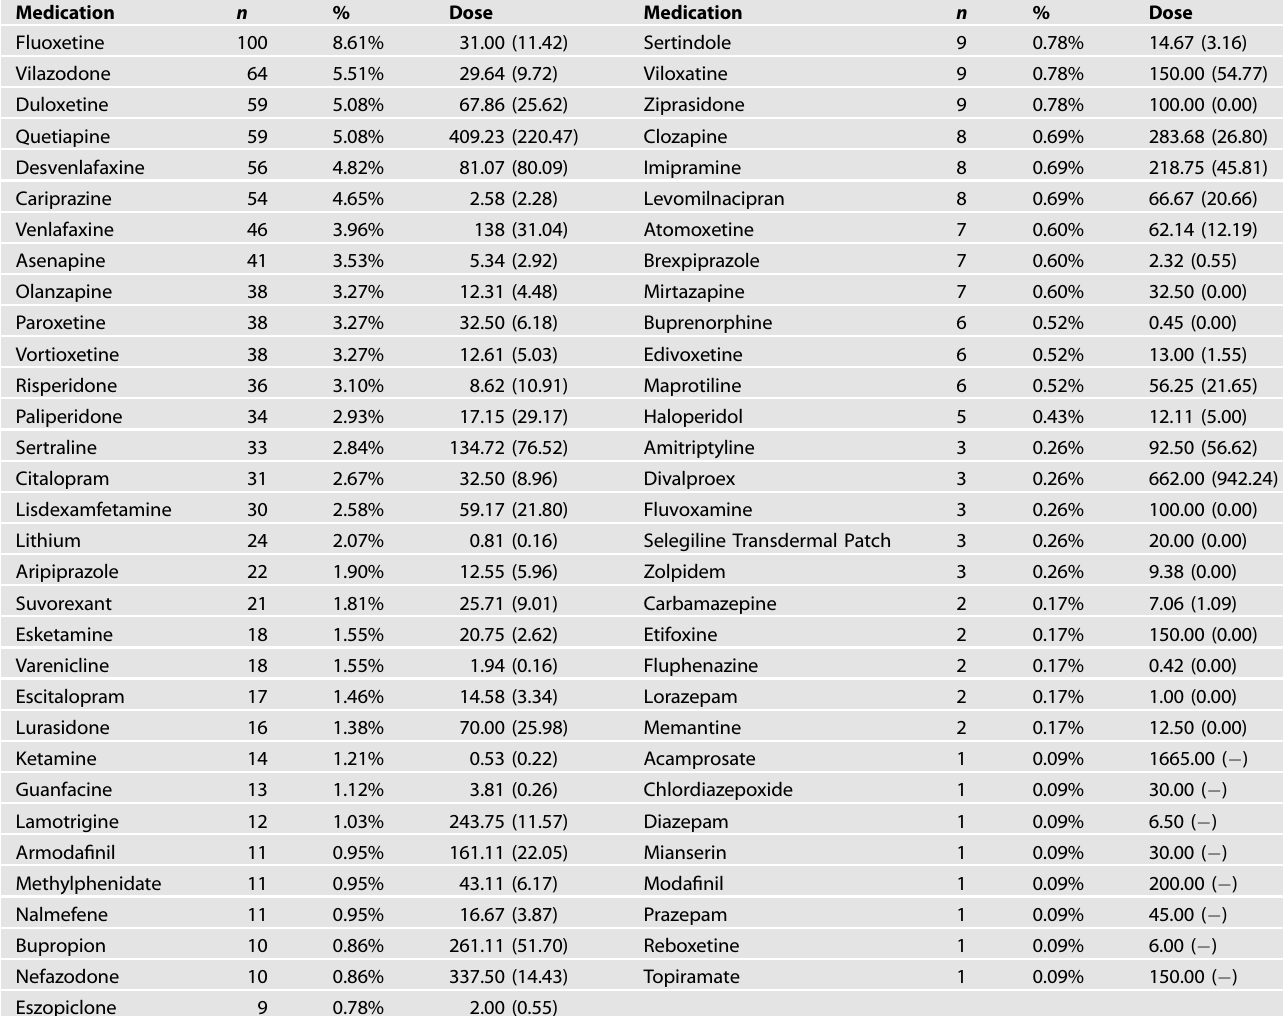
Table 1. Percentage of Medications Included in Pairwise